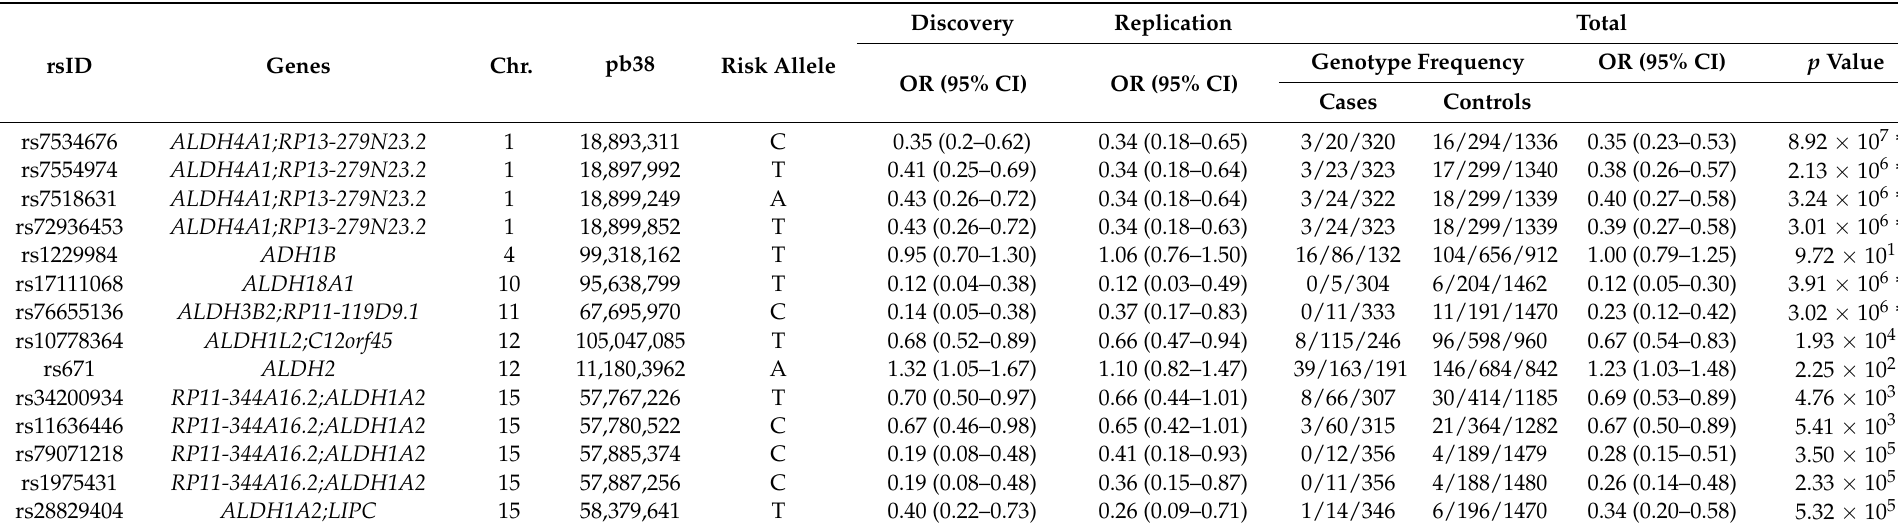
Table 2. Associations between ALDH gene polymorphisms and nasopharyngeal carcinoma